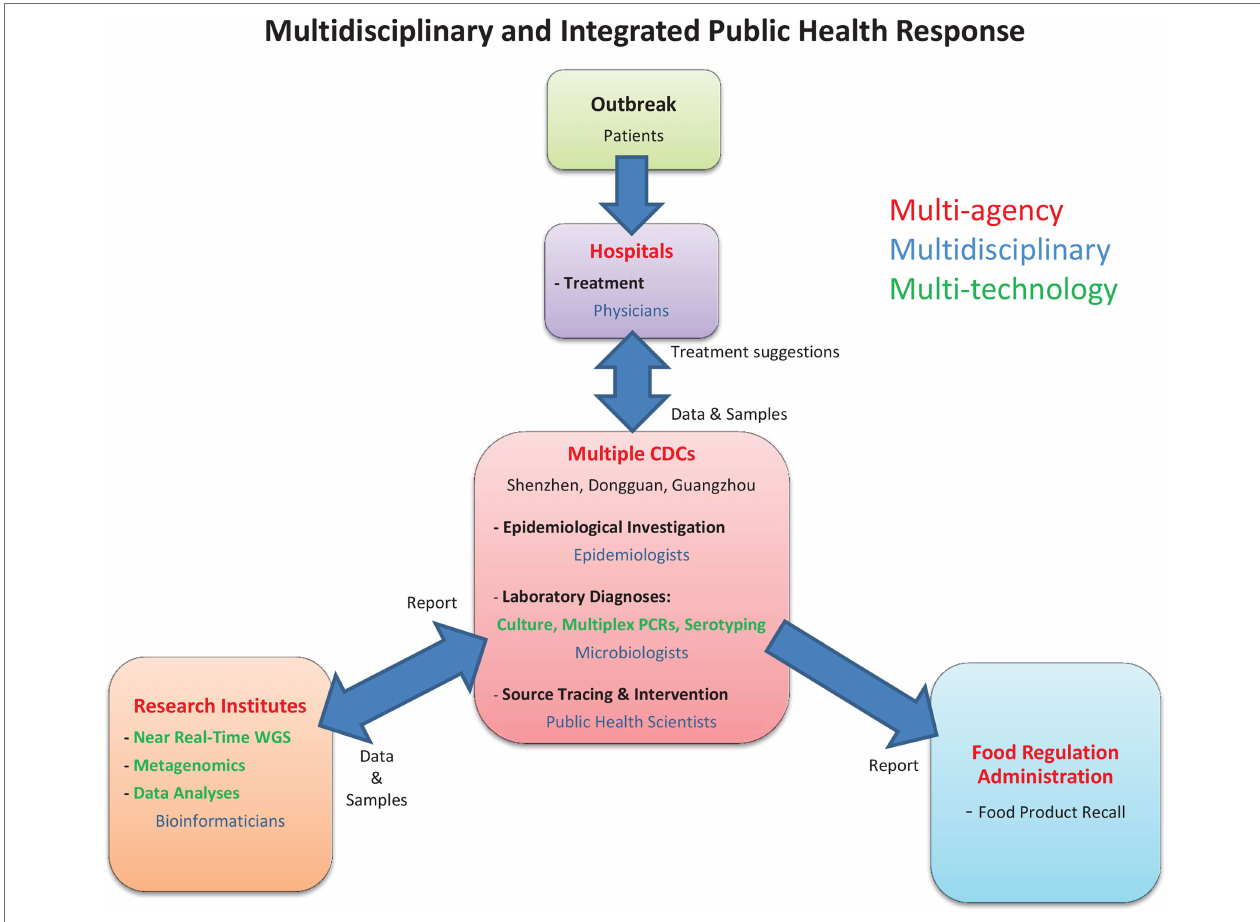
FIGURE 1 | An overview of the multidisciplinary and integrated public health response framework. In the current Salmonella Enteritidis outbreak, the three CDCs (Shenzhen, Dongguan, and Guangdong) played a central role in coordinating a multicenter effort to conduct epidemiological investigation, laboratory diagnoses, near real-time whole-genome and metagenomics analyses, and genomic source tracing to stipulate intervention